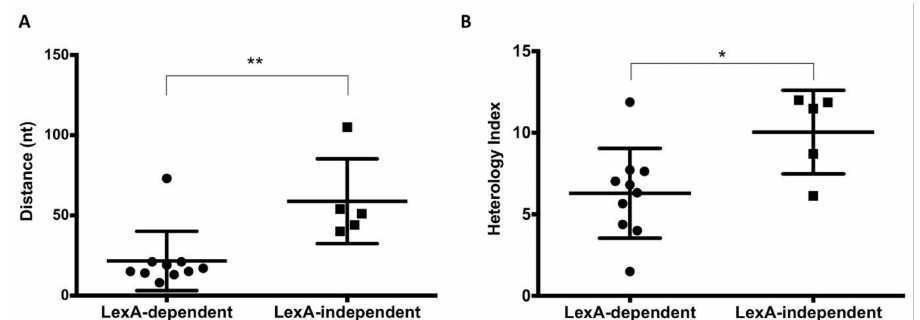
Figure 4. ( A ). Correlation between LexA-dependent and LexA-independent bistability and the distance of the SOS box. Statistically significant differences are shown ( p -value: * p < 0.05; ** p < 0.01). ( B ). Correlation between LexA-dependent and LexA-independent bistability and the heterology index (HI) of the SOS box. In genes that show LexA-dependent bistability and have more than one LexA box ( recN , dinI and lexA ), only the closest LexA box with lower HI was